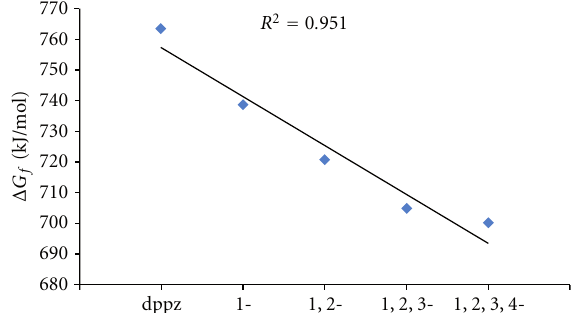
F 5: e plot of for dppz, and 1-, 1,2-, 1,2,3-, and 1,2,3,4- chlorosubstituted Δ𝐺𝐺 𝑓𝑓